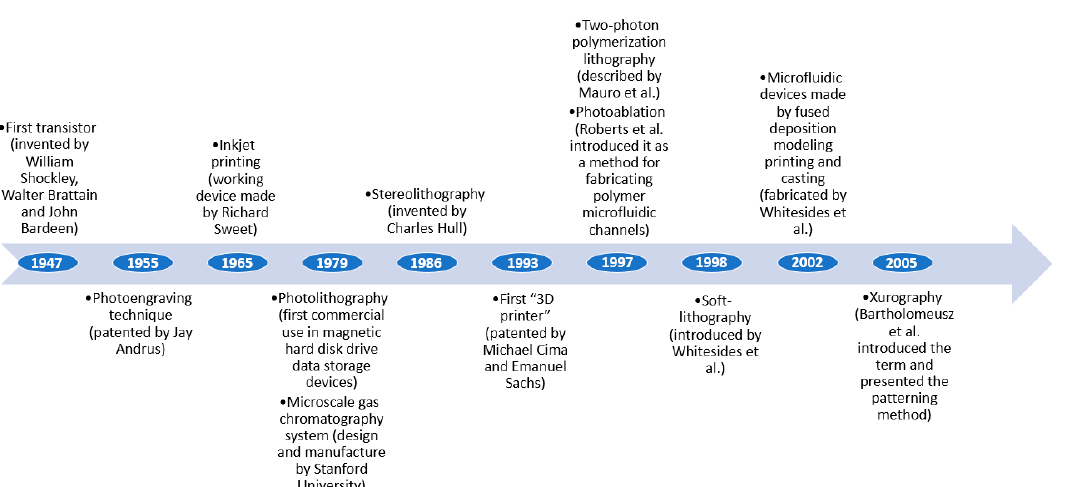
Table 2. The classification of microfluidic fabrication techniques.